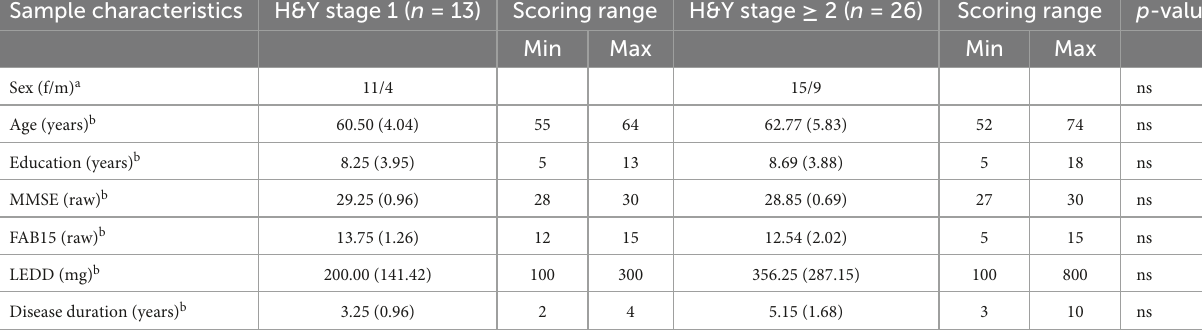
TABLE 3 Descriptive statistics on H&Y-based